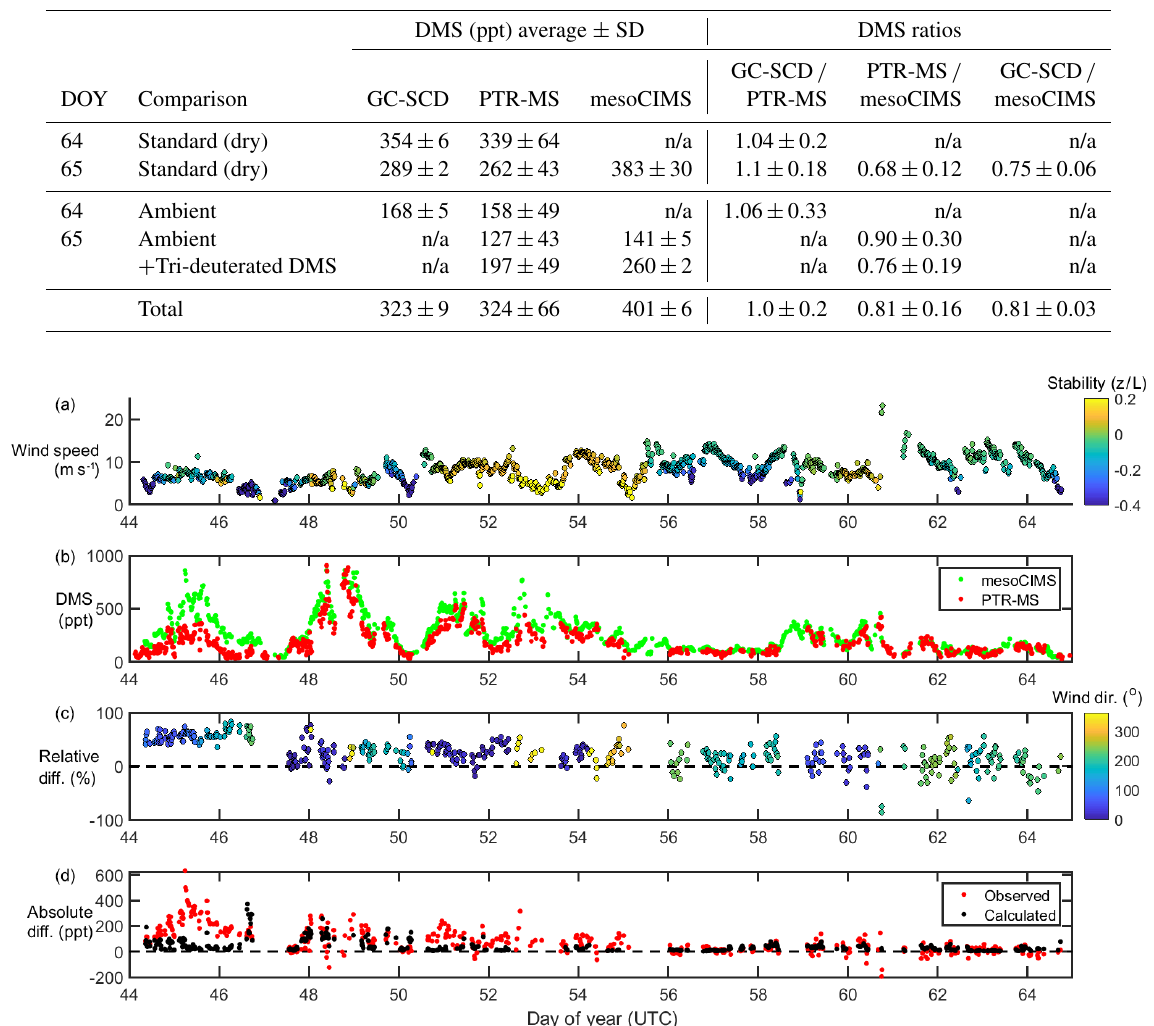
Figure 1. From top to bottom, wind speed and stability (a) , DMS a measurements from mesoCIMS and PTR-MS (b) , relative difference (normalised to mesoCIMS) according to absolute wind direction (c) , and absolute observed and calculated difference between mesoCIMS and PTR-MS (d) , taking into account the expected DMS concentration gradient (Eq.